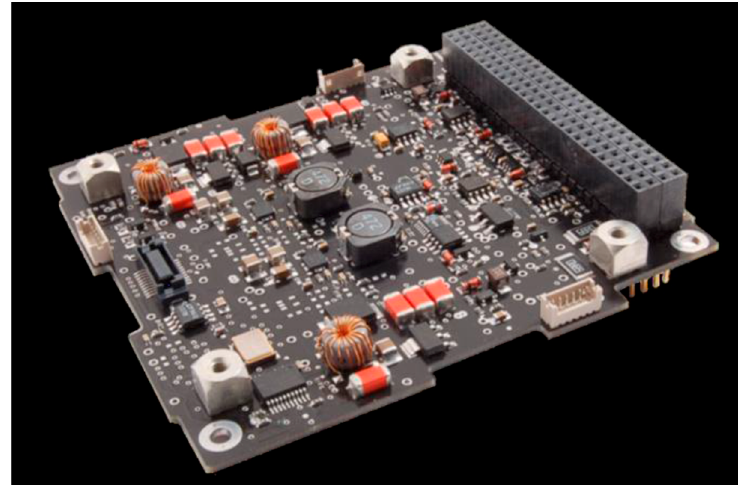
Figure 10. PMAD Developed by Clyde Space Industries [25].